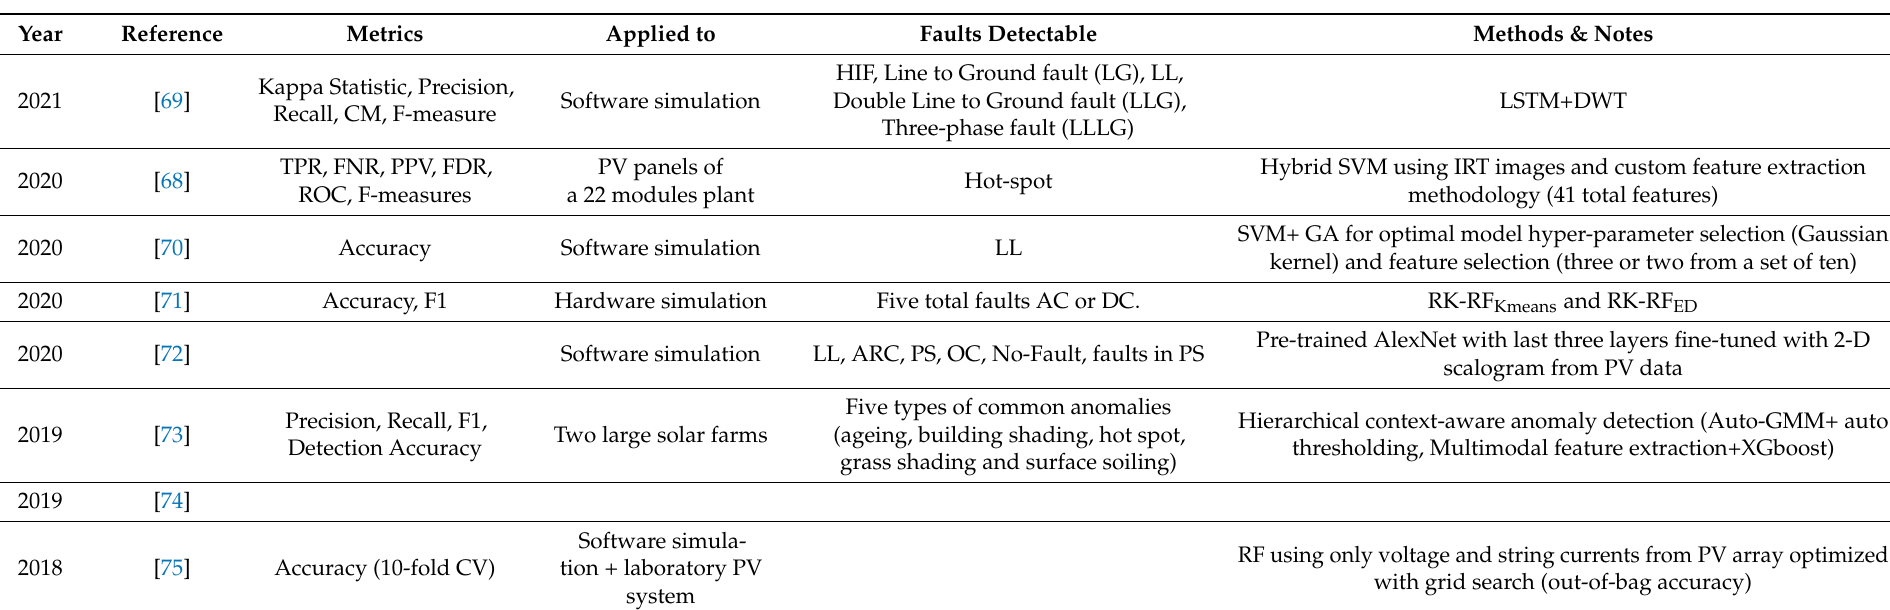
Table 5. Papers for fault/anomaly detection and diagnosis in PV. Publication year considered: